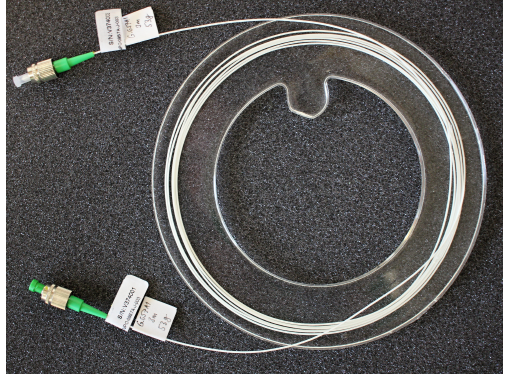
Figure 3. Fibre-optic interferometer measuring probe.